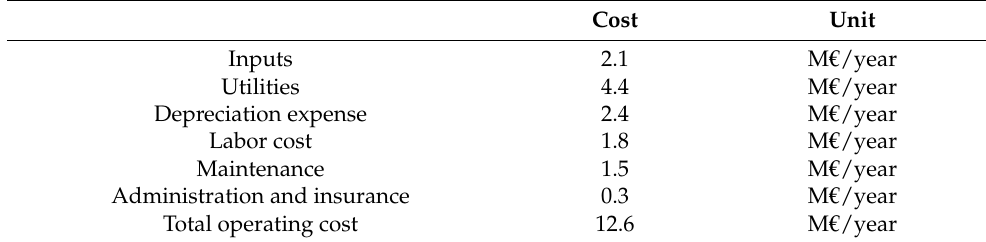
Table 9. Annualized operating cost for the microbial oil process studied.